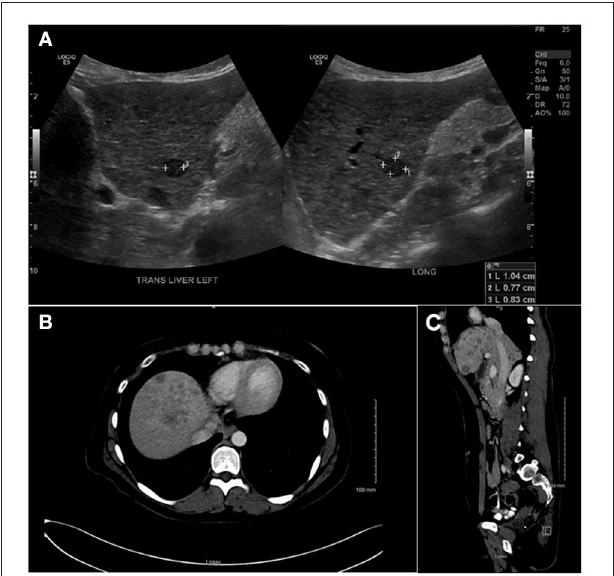
FIGURE 2 | (A) Liver ultrasound showing multiple hypo-echoic lesions ranging between 0.5 and 3.3cm. (B) A liver computerized tomography scan showing multiple hypo-echoic lesions with peripheral rim of increased enhancement. (C) A magnetic resonance imaging (sagittal view) showing same as (A,B)